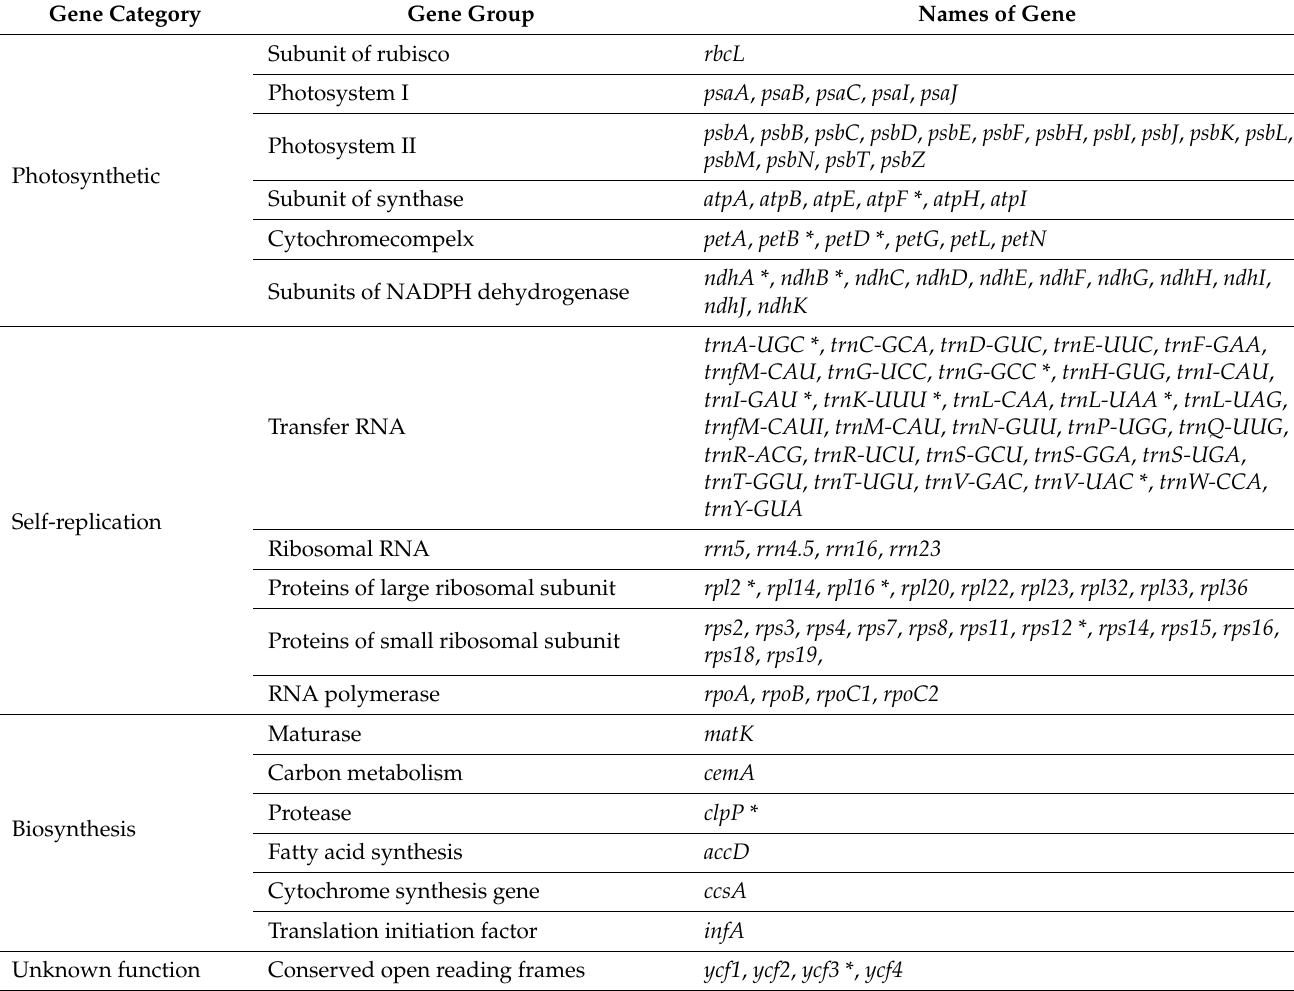
Table 3. List of annotated genes encoded by the four Crataegus chloroplast genomes.